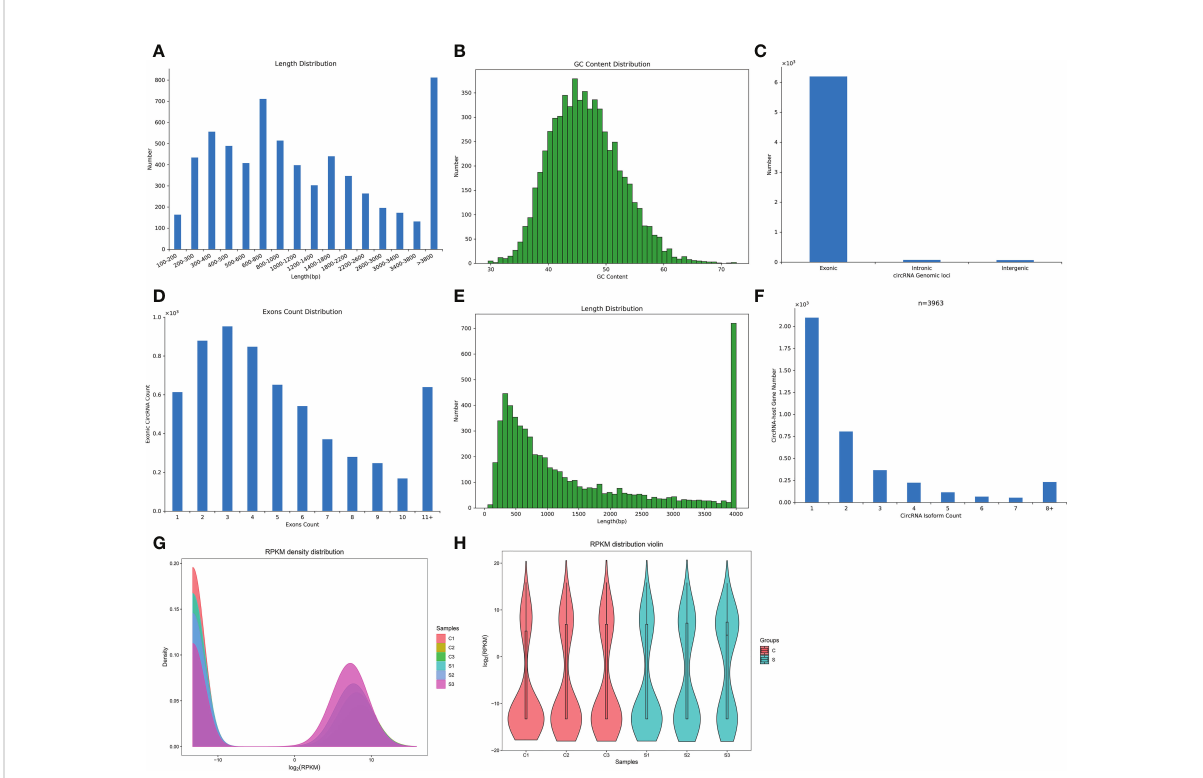
FIGURE 2 The characteristics and expression pro fi les of circRNA in the subacute stage after SCI in mice. (A) The length distribution of circRNAs. (B) The GC content distribution of circRNAs. (C) The statistical diagram of circRNAs sources. (D) The exons count distribution of circRNAs. (E) : The exons length distribution of circRNAs. (F) The distribution of circRNA host genes numbers and circRNA isoform count. (G) CircRNA expression density curve. The horizontal axis represent the log (RPKM) value, the higher the value, the higher the circRNA expression level; the vertical axis represent the corresponding relative density value, that is, the number of circRNAs on the horizontal axis/the total number of circRNAs. Each color represents a sample, the area of each region is 1, and the peak of the density curve represents the region with the most concentrated circRNA expression in the entire sample. (H) Violin plot of circRNA expression calculated using RPKM Reads. The horizontal axis represent the sample name, and the vertical axis represent the log (RPKM) value. The width of each violin re fl ects the number of circRNAs at that expression